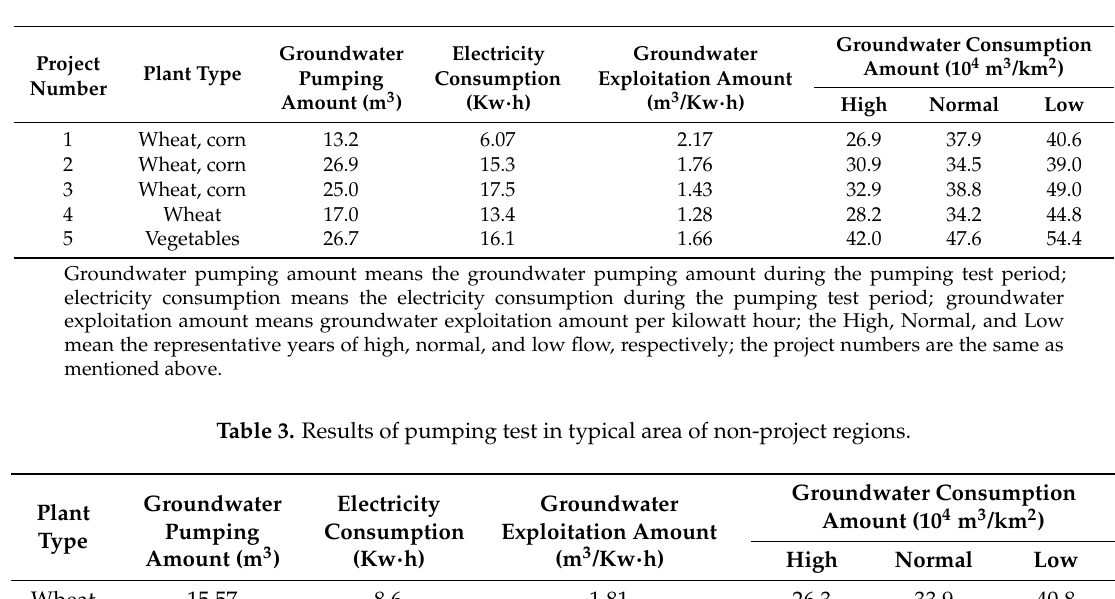
Table 2. Results of pumping test in typical area of project regions.